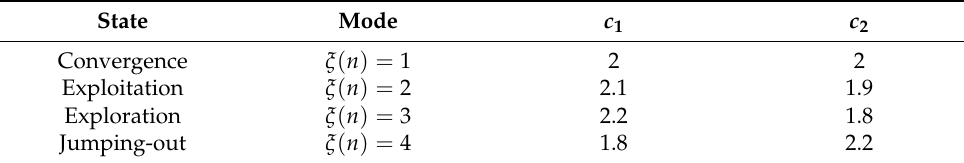
Table 1. Strategies for selecting c 1 and c 2